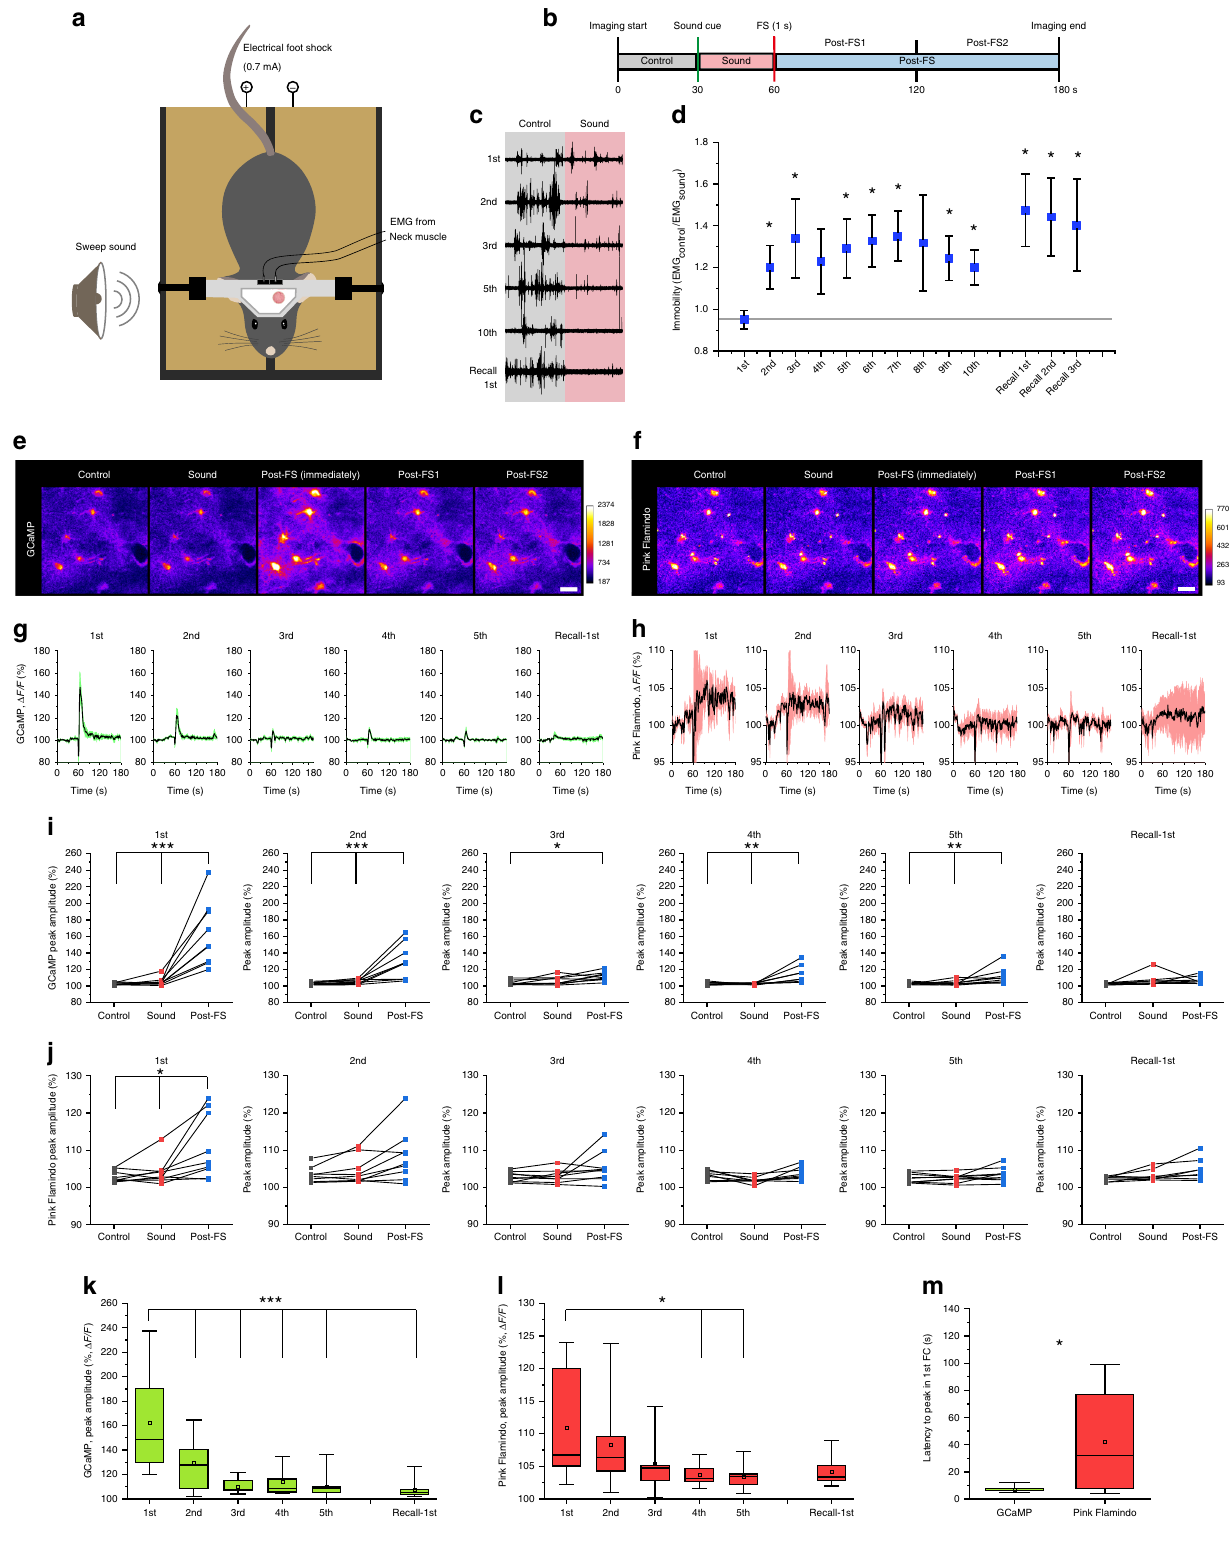
drugs) expressed in astrocytes via AAV8-GFAP-HA-rM3D-mCi- trine 34 (Fig. 8a). A clear sustained cAMP elevation in astrocytes was observed by Pink Flamindo after CNO (Clozapine-N-Oxide) injection, lasting more than 2 h (Fig. 8b, c) (0 min: 99.2 ± 0.6%, 60 min: 180.6 ± 21.4%, 160 min: 174.9 ± 16.6%). Considering that one